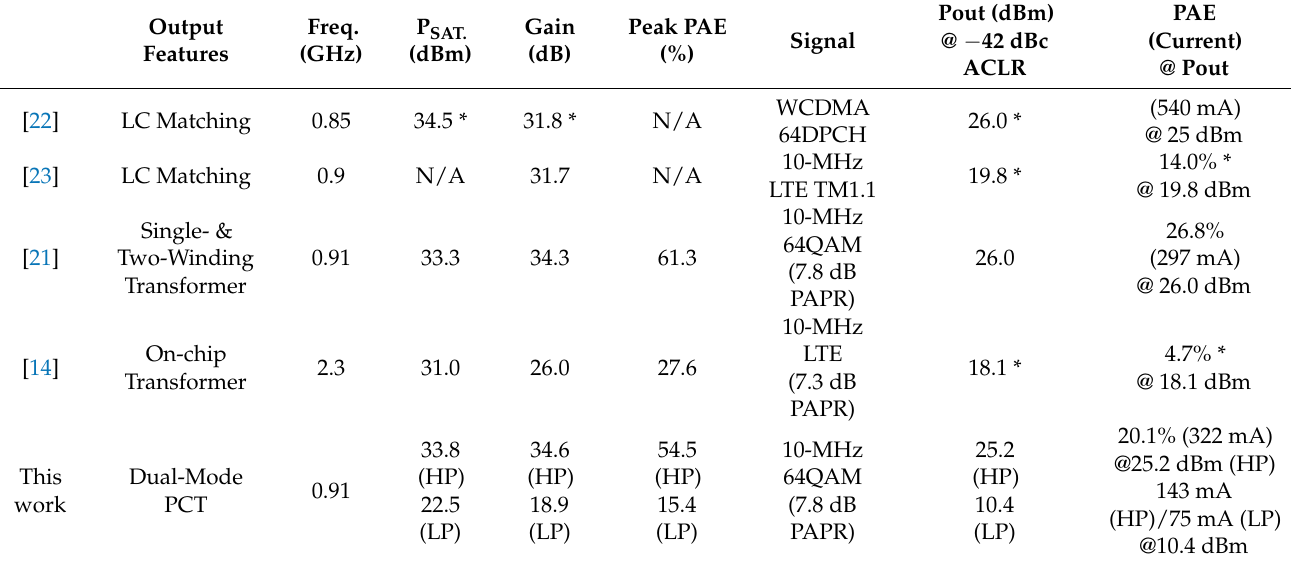
Table 2. Performance comparison with linear femto-cell HBT